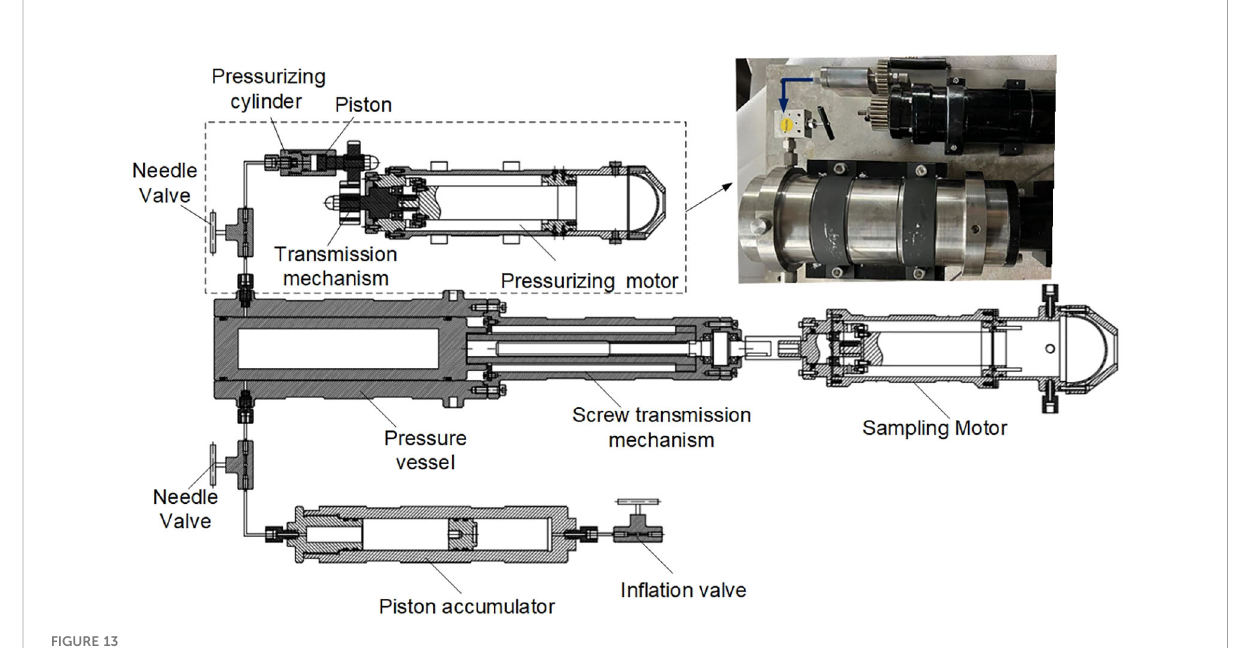
FIGURE 13 The pressurizing device of